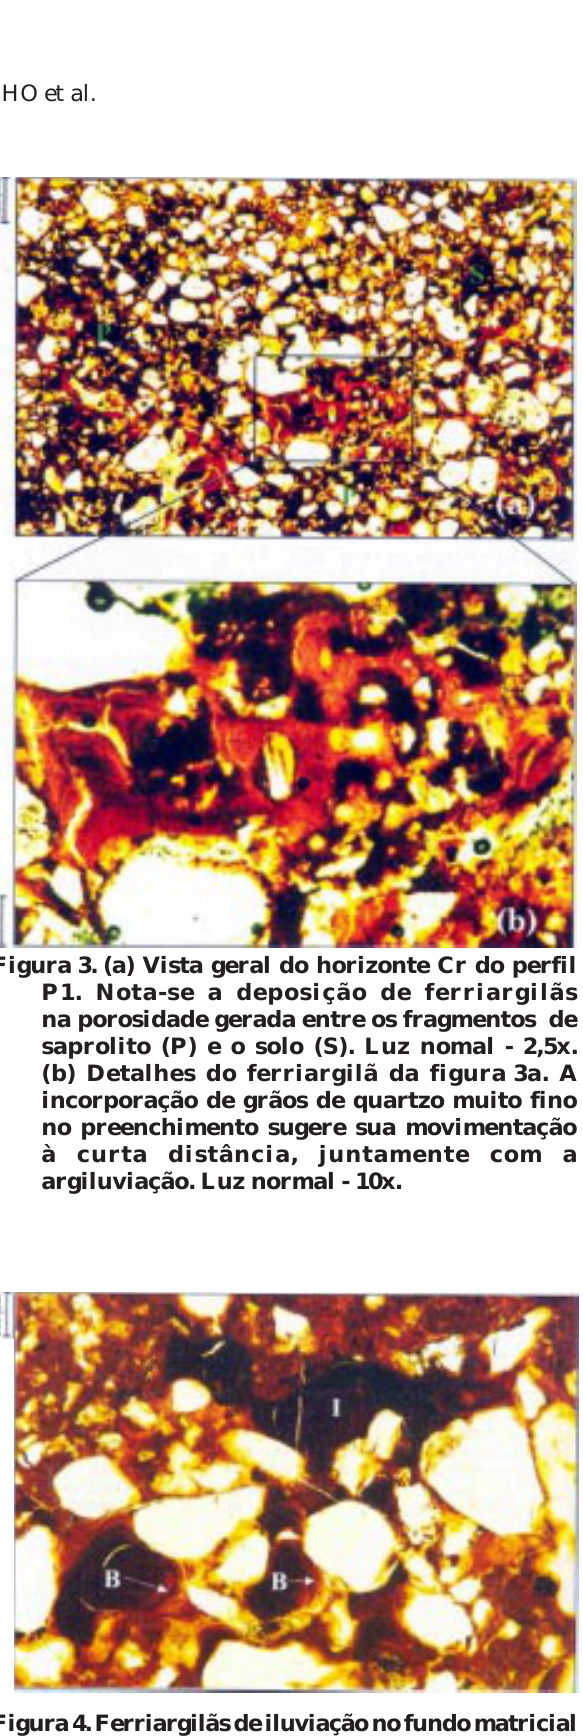
Figura 4. Ferriargilãs de iluviação no fundo matricial interglebular do horizonte F (perfil P2). Notam- se os bandeamentos no cutã parcialmente isótico (B) sob luz natural e a completa isotropia do cutã acima (I). Luz normal -